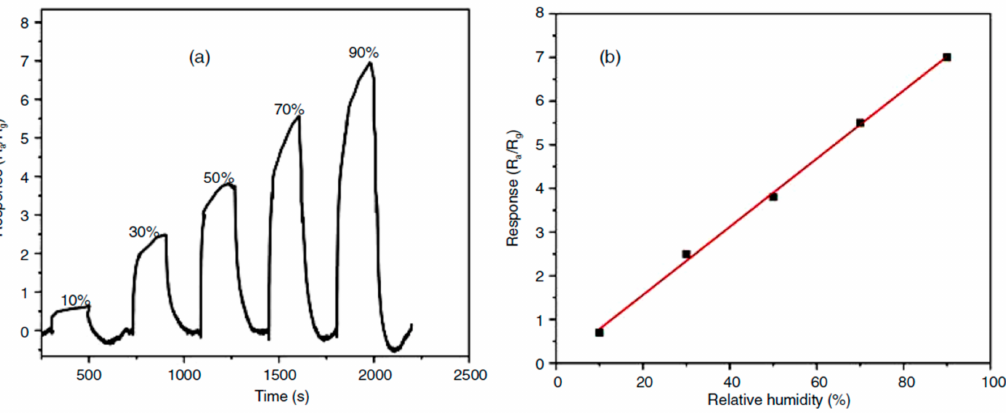
Figure 19. ( a ) Ce 2 O gas sensing performance towards humidity (10–90%); ( b ) linear fitting of response. Reprinted from Ref.